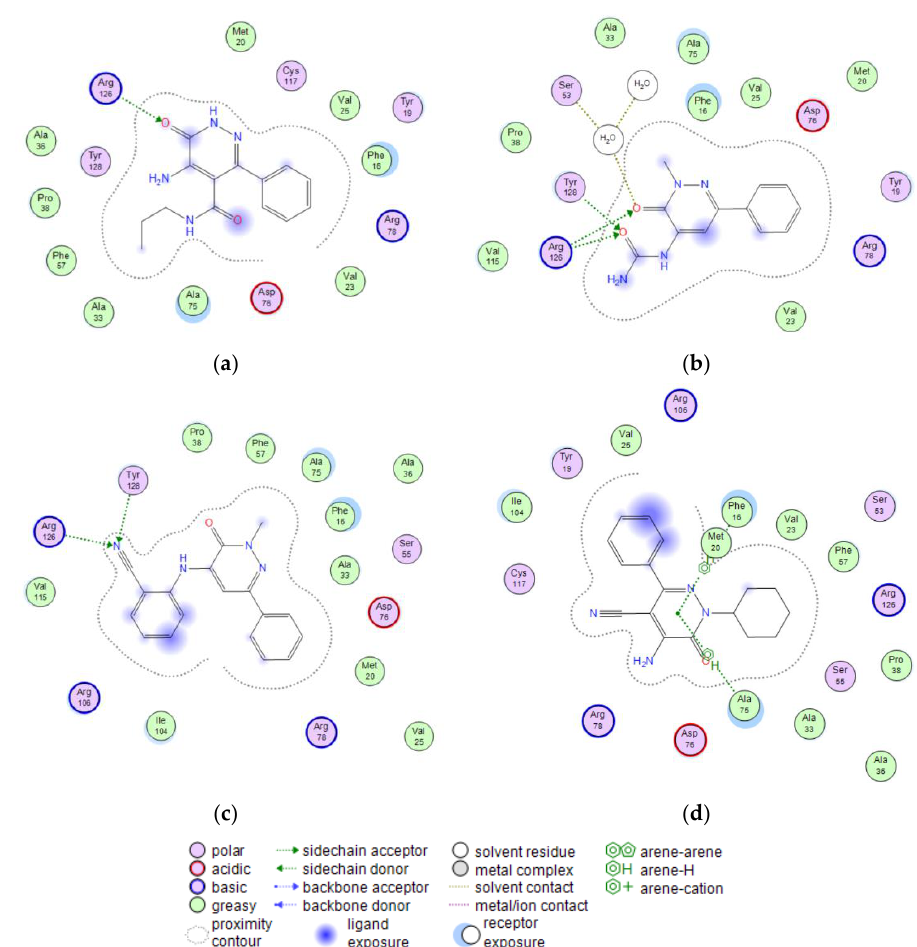
Figure 3. ( a ) 2D interaction between 4b and FABP4. ( b ) 2D interaction between 25a and FABP4. ( c ) 2D interaction between 30b and FABP4. ( d ) 2D interaction between 22 and FABP4.